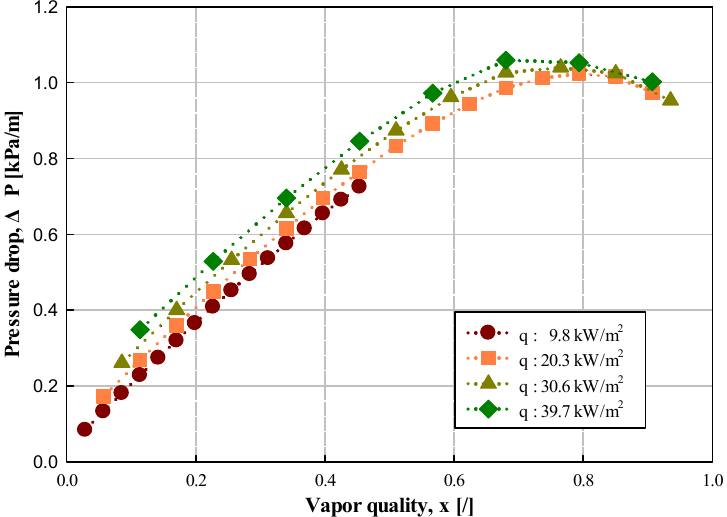
Figure 14. Variation of experimental pressure drop according to various heat fluxes at constant mass fluxes and saturation temperature (200 kg/(m 2 ·s) and − 20 °C). fluxes and saturation temperature (200 kg/(m 2 · s) and − 20 ◦ C). The pressure drop measured under the experimental conditions is the sum of